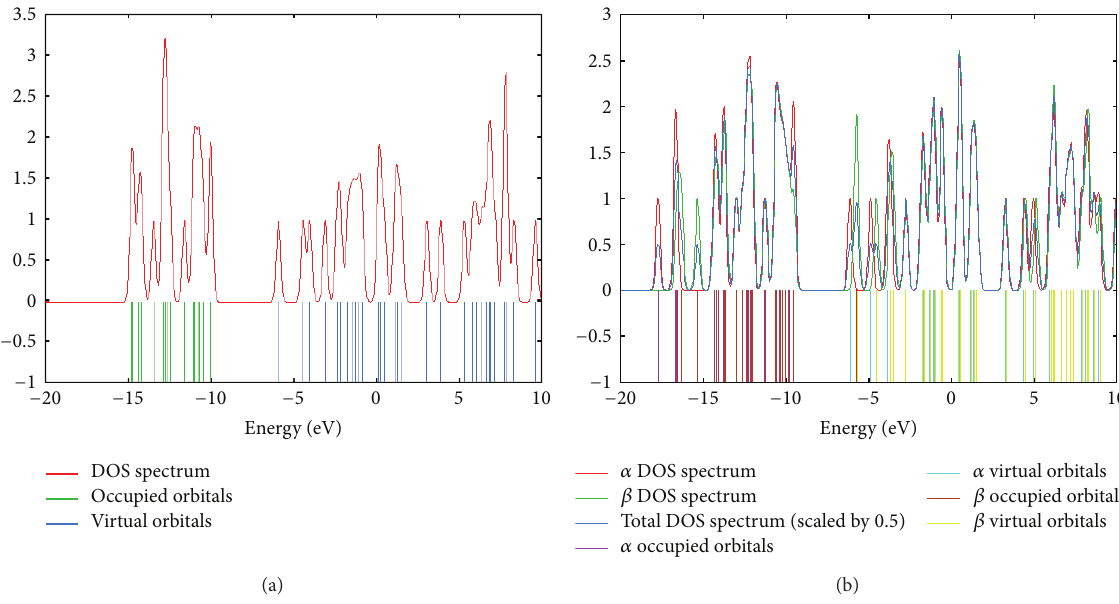
Figure 4: DOS spectra of W 2 O 6 surfaces (a) before adsorption of NO and (b) after adsorption.